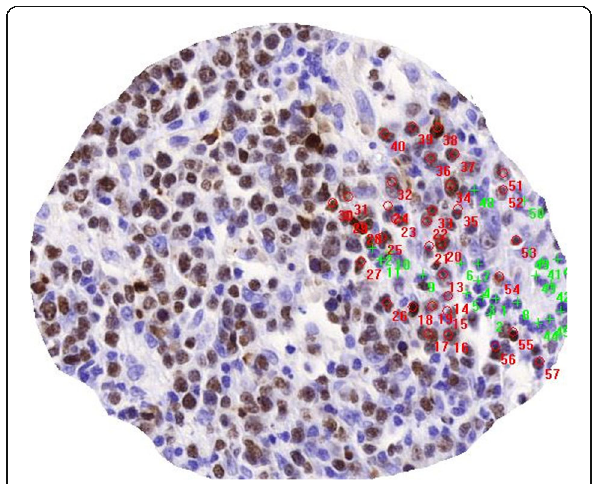
Fig. 3 Manual count of the digital analysis, the red dots are the positive cells for